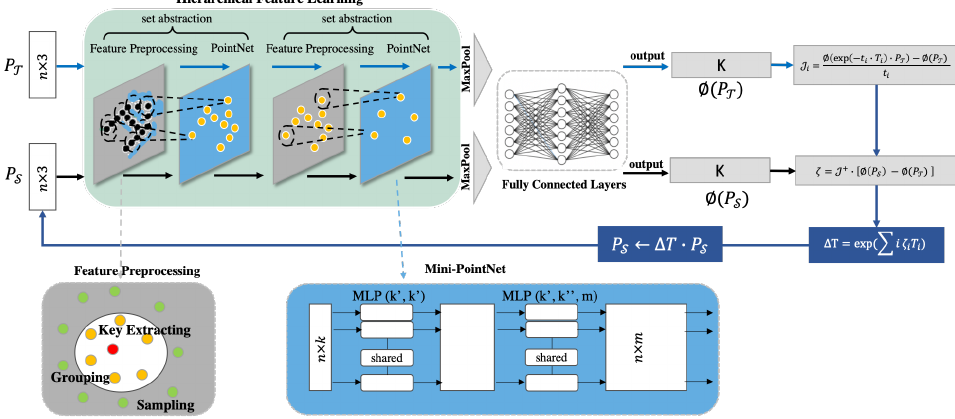
Figure 1. Point clouds input source P S and target P T are passed through feature learning and a MLP to compute the feature vectors φ ( P S ) and φ ( P T ) . The jacobian matrix J is computed by using the φ ( P T ) . Pose information ∆ T will be updated incrementally if the value is higher than the thresh. During the training, one lose function is used, which is based on the difference between the estimated transform and the ground truth